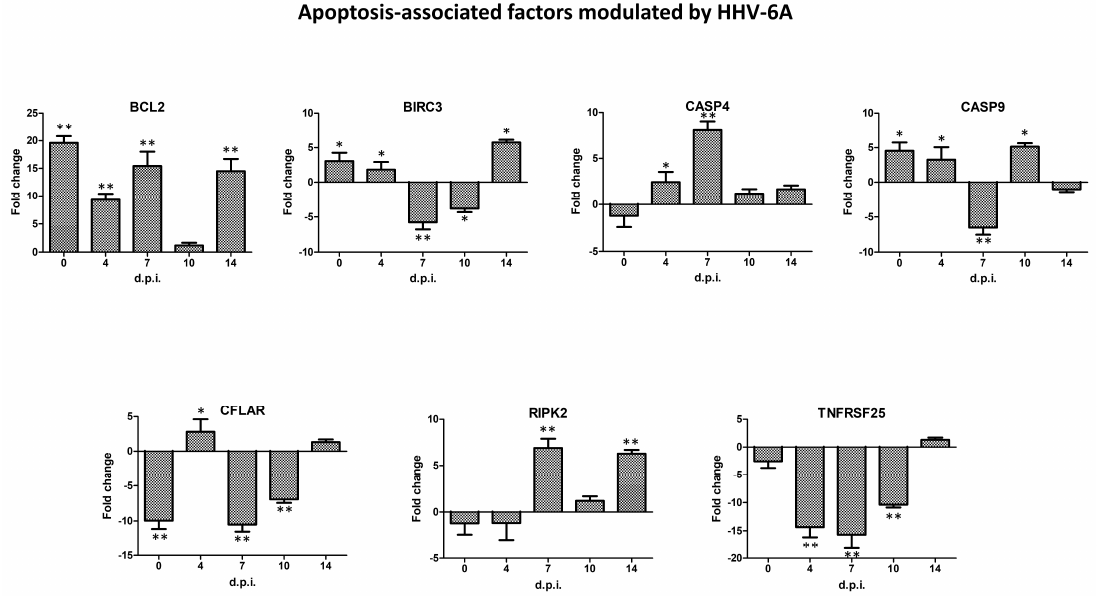
Figure 8. Expression kinetics of apoptosis-associated factors modulated by human herpesvirus 6A (HHV-6A) infection in primary human dermal fibroblasts. At each time p.i. (d.p.i. = days post-infection), cell samples were collected and analyzed by specific qPCR microarray. Results are expressed as mean values of fold change (infected cells vs. controls) ± SD of duplicate samples from two independent experiments. * pc < 0.01; ** pc <